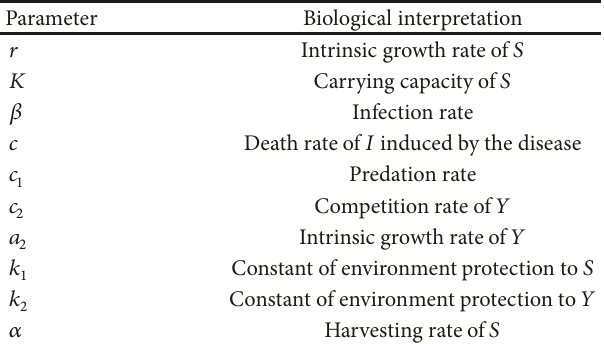
Table 1: Biological interpretation of